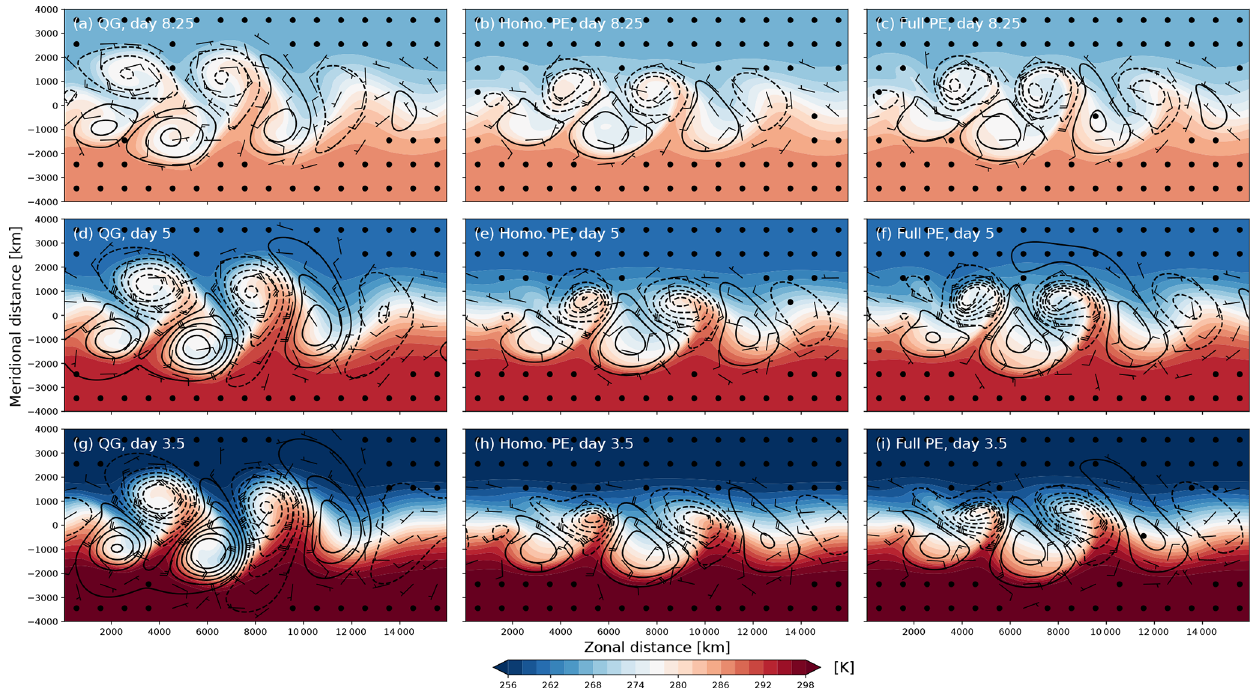
Figure 4. Sensitivity of the downstream development to the initial jet speed in a three-layer channel model on a β plane using jet speeds of (a–c) 30ms − 1 , (d–f) 50ms − 1 , and (g–i) 70ms − 1 . The presented lead times are scaled linearly with the initialized jet speed, such that the rows show the development after (a–c) 8.25d, (d–f) 5d, and (g–i) 3.5d lead time, respectively. Columns show the different versions of the model: panels (a, d, g) show QG, panels (b, e, h) show homogeneous-density PE, and panels (c, f, i) show full PE. Barbs and contours are the same as in Fig. 2, and panels (d–f) are identical to panels (g–i) of Fig. 2 except for the temperature scale.